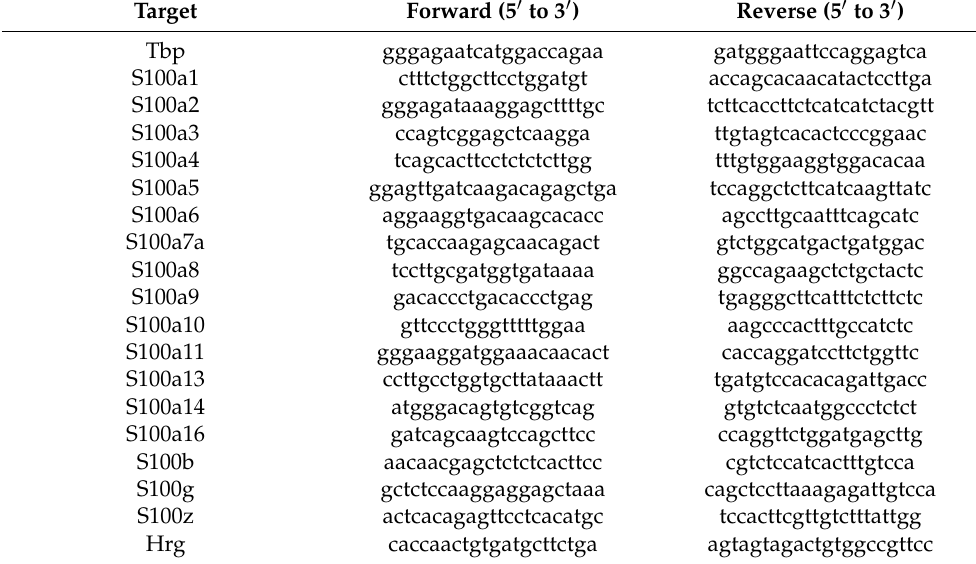
Table 2. RT-qPCR Primer